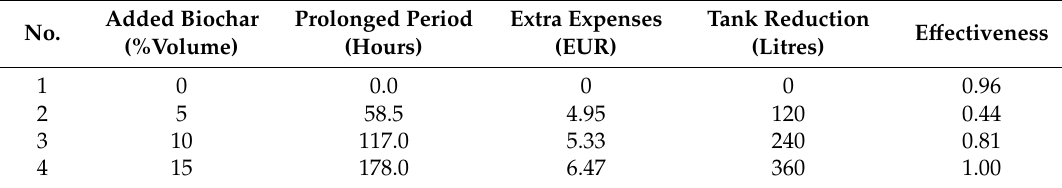
Table 6. Results for the sample thickness of 300